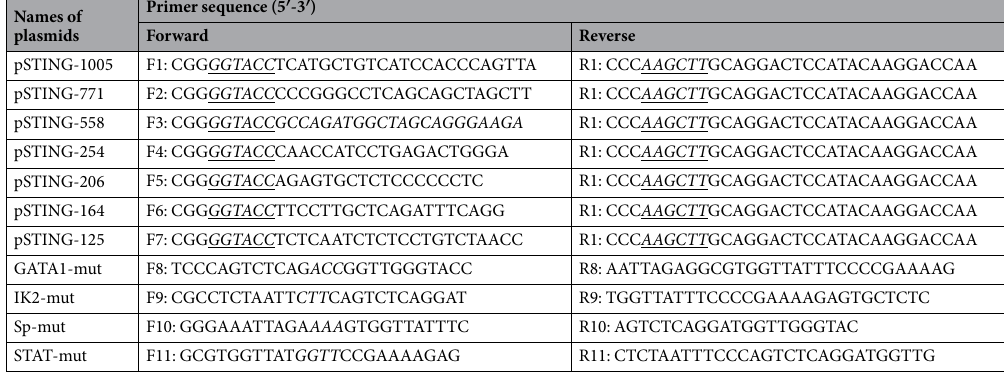
Table 1. Sequences of oligonucleotides used to clone the mSTING gene promoters and site-directed mutagenesis. Primers for cloning promoter of the mSTING gene: KpnI restriction site (underlined and italics) and protective bases were introduced to the 5 ′ end of the forward primers, and HindIII restriction site (underlined and italics) and protective bases were added to the 5 ′ end of the reverse primers. Primers for site- directed mutagenesis: the bold italics indicated the mutation